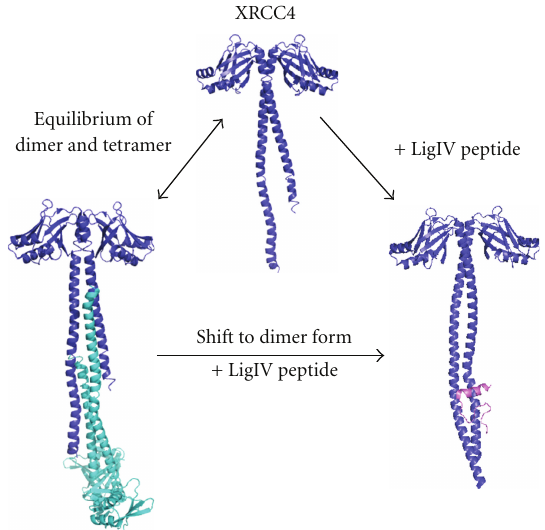
Figure 10: XRCC4 dimer, tetramer, and binding with DNA ligase IV peptide. The equilibrium is shifted to dimer when DNA ligase IV peptide binds to